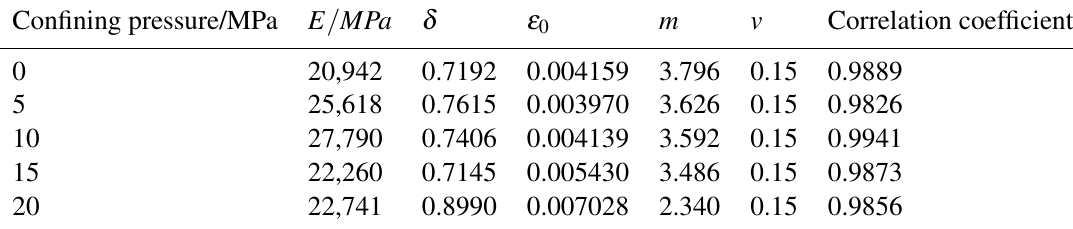
Fig. 3 Microcomputer controlled rock triaxial test system. Table 1 Fitting parameters under different confining